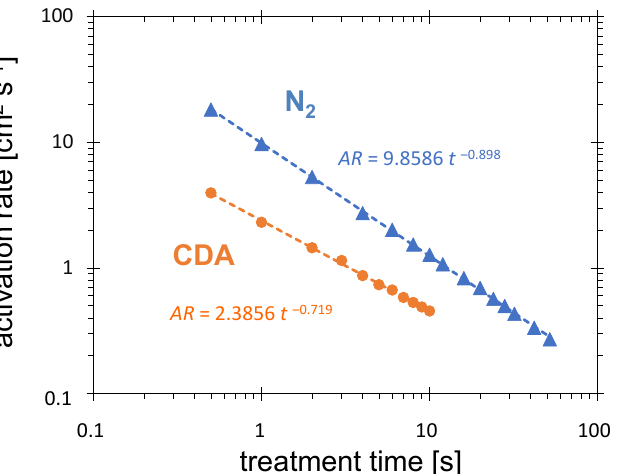
Figure 8. Influence of treatment time on the activation rate for CDA and N 2 flow of 8.0 SLM, distance between the PCPG tip and the HDPE substrate of 5.5 mm, and the PCPG input power of 8.0